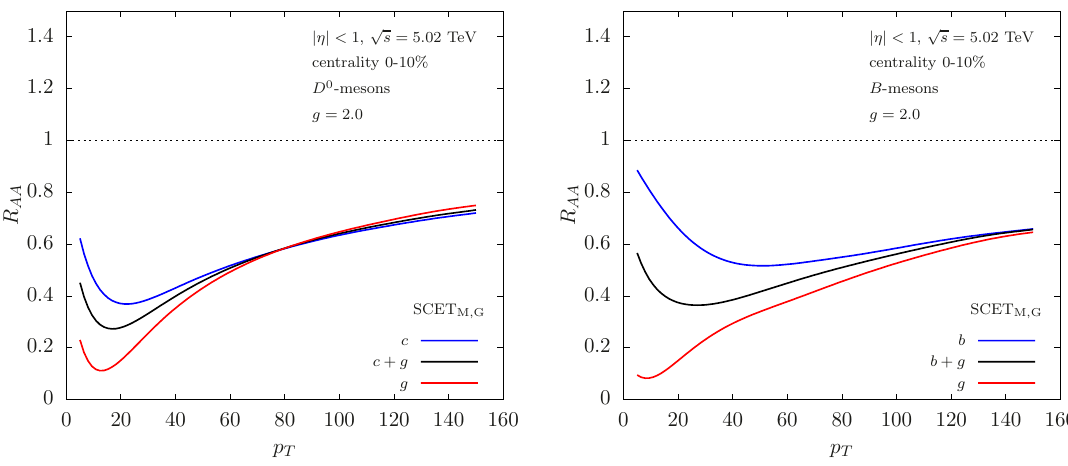
Figure 11 . Nuclear modi(cid:12)cation factor R AA for D 0 mesons (left) and B -mesons (right). As an p example, we choose s NN = 5 : 02 TeV, j (cid:17) j < 1 and 0 (cid:0) 10% centrality. In black the standard R AA is shown as in (cid:12)gures 9 and 10. In blue, we show the suppression for the \heavy quark only" case. This result is obtained by calculating both the proton-proton baseline as well as the medium e(cid:11)ects with only charm (left) and bottom quark fragmentation functions (right). In red, the analogous result is shown for the \gluon only"